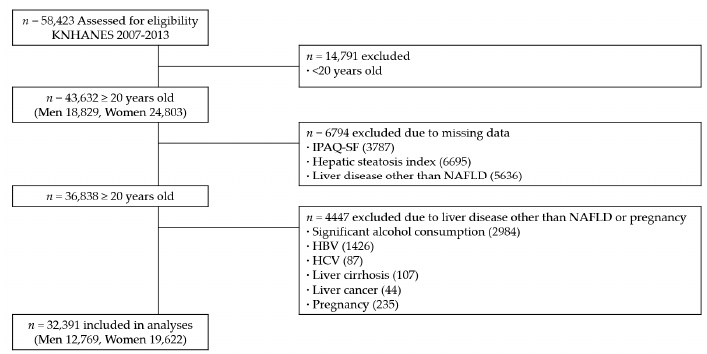
Figure 1. Flow diagram of participant inclusion and exclusion in the current study using data from the Korea National Health and Nutrition Examination Surveys (KNHANES IV, V, and VI). IPAQ-SF, International Physical Activity Questionnaire Short Form; NAFLD, nonalcoholic fatty liver disease; HBV, hepatitis B virus; HCV, hepatitis C